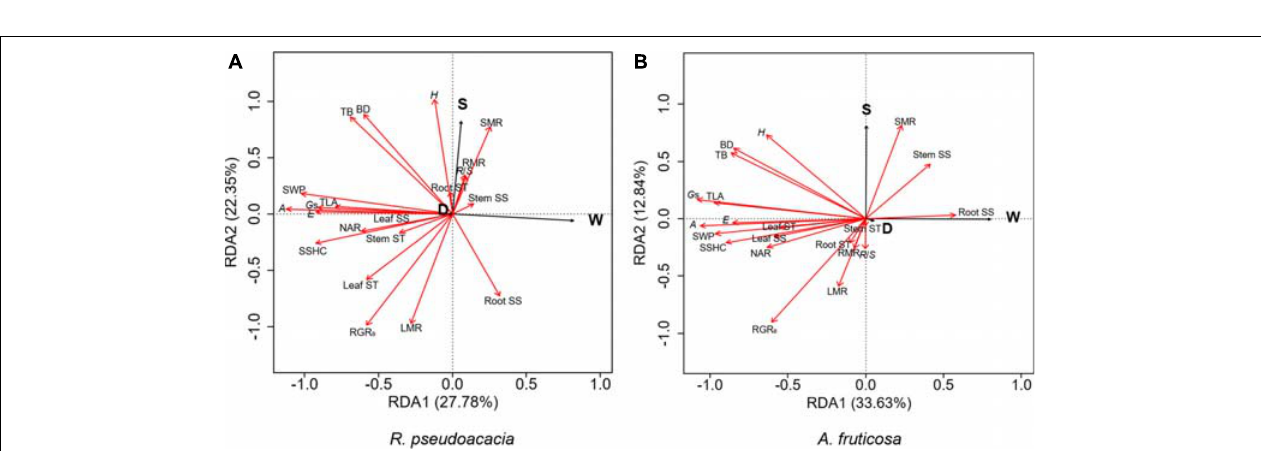
FIGURE 6 | Redundancy analysis (RDA) of the effects of defoliation (D), water availability (W), and plant size (S) on plant traits of Robinia pseudoacacia (A) and Amorpha fruticosa (B) . The black line vectors represent treatment factors (defoliation, water supply, and plant size), and the red line vectors represent plant traits. H , height; BD, basal diameter; TB, total biomass; TLA, total leaf area; RGR B , relative growth rate of total biomass; LMR, leaf mass ratio, SMR, stem mass ratio, RMR, root mass ratio, RS, root-shoot ratio; A , the net photosynthetic rate, E , transpiration rate, G s , stomatal conductance; NAR, net assimilation rate; SSHC, stem-specific hydraulic conductivity; SWP, stem water potential; Leaf SS, leaf soluble sugar concentration; Stem SS, stem soluble sugar concentration; Root SS, root soluble sugar concentration; Leaf ST, leaf starch concentration; Stem ST, stem starch concentration; Root ST, root starch concentration.